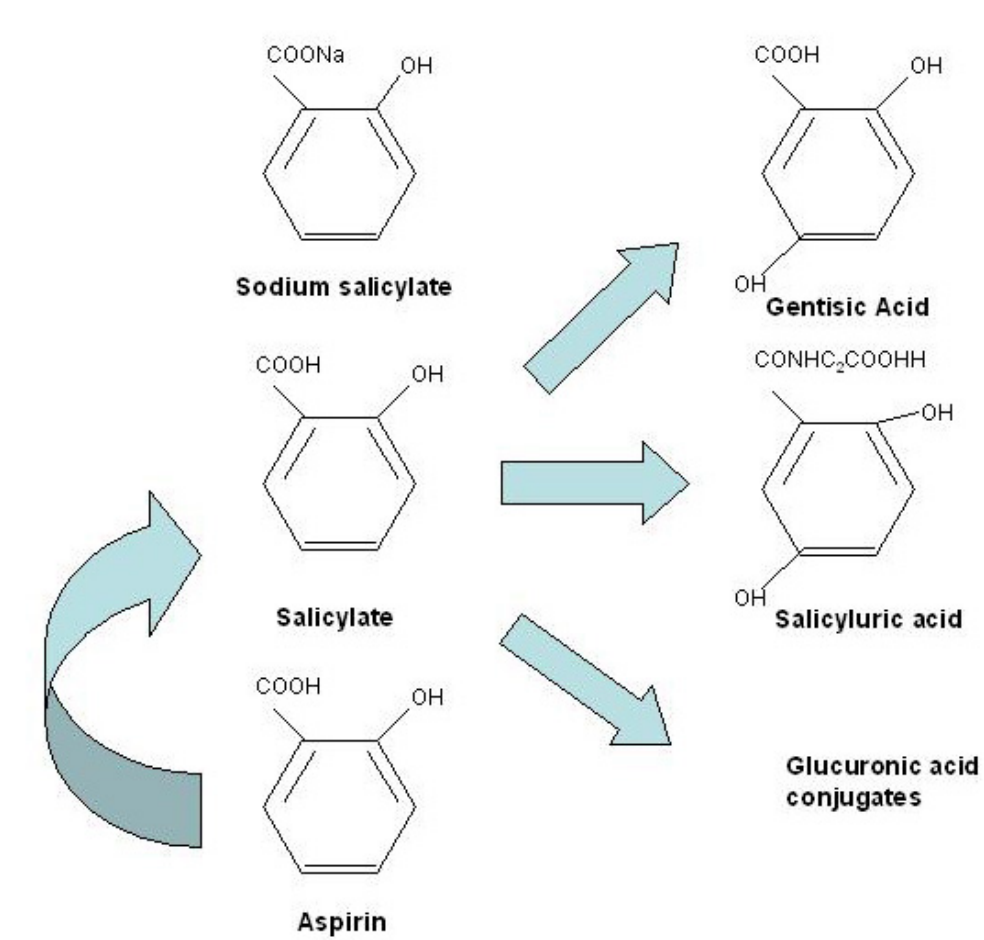
FIGURE 1. In vivo pathway of aspirin metabolism. After oral administration, aspirin is rapidly absorbed and first pass metabolism induces the formation of salicylates with a short half-life in the order of 15 to 20 mins, detectable before salicylates are measureable. Clearance of salicylate and therefore aspirin, can occur via 5 pathways, with all metabolites being excreted via the